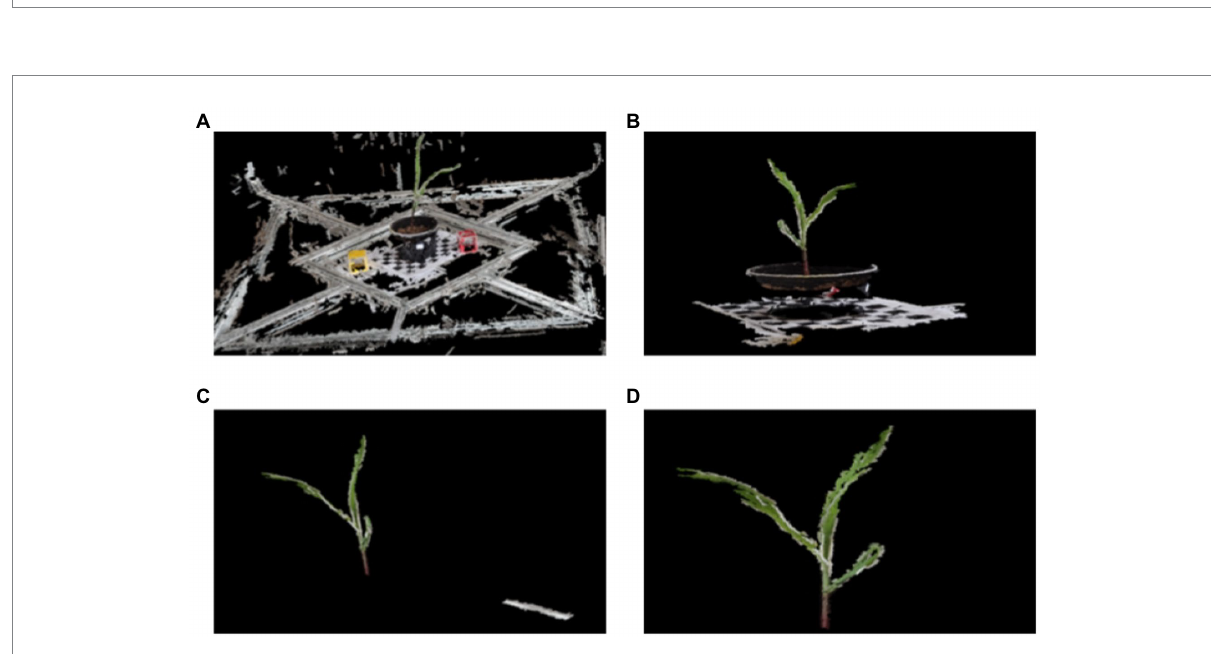
FIGURE 4 Segmentation Chart of Maize Seedlings Based on Euclidean Clustering. The segmentation process from (A–D) shows that the irrelevant background segmentation such as carrier table, flower pot and checkerboard grid can be removed using the Euclidean clustering segmentation